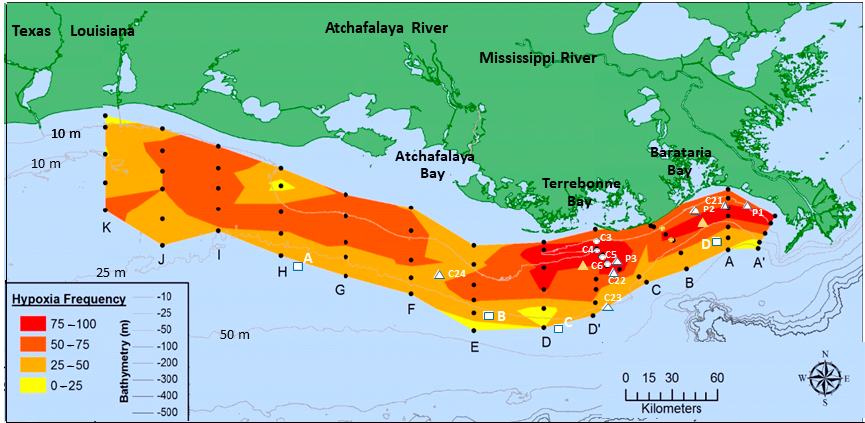
Figure 1. The frequency of bottom-water hypoxia occurrence from mid-summer shelfwide hypoxia mapping from 1985 through 2014 (modified from [13]). Frequency is determined from stations for which there are data for at least half of all cruises (identified by black dots and letters). Macroinfauna data from studies used in the community comparisons are indicated by white circles [14,15], yellow circles for a long-term dissolved oxygen time series [16], orange triangles [15], open triangles [17], squares [18], and studies [19] near station C6 of Rabalais et al. [15]. A phytoplankton-enhanced upper water column contributes to the flux of organic carbon to the lower water column and seabed. The water column is stratified seasonally by both temperature and freshwater inflow. Respiration of carbon in the bottom layer exceeds the resupply of oxygen from the surface waters across the pycnocline, and bacterial respiration drives bottom-water dissolved oxygen to levels insufficient to support most marine life [2]. Hydrographic data that identify areas of bottom- water oxygen deficiency for this area date only to the early 1970s [20] but dated sediment cores identify numerous indicators of ecosystem change from much earlier. Indicators of ecosystem change include increased accumulation of carbon and diatom remnants, shifts in C, N, and S isotopic signatures, increase in glauconite minerals (related to worsening redox conditions in surface sediments), loss of biodiversity of ostracods and foraminiferans, and species shifts within diatoms and foraminiferans [12,21]. Shifts in biological and chemical indicators of increased productivity in overlying waters and worsening oxygen deficiency in the bottom waters paralleled increased nitrogen loads from the Mississippi River to the continental shelf west of the Mississippi River delta beginning approximately in the 1950s, accelerating in the 1960s to 1970s, and becoming most pronounced in the 1990s [12,21].